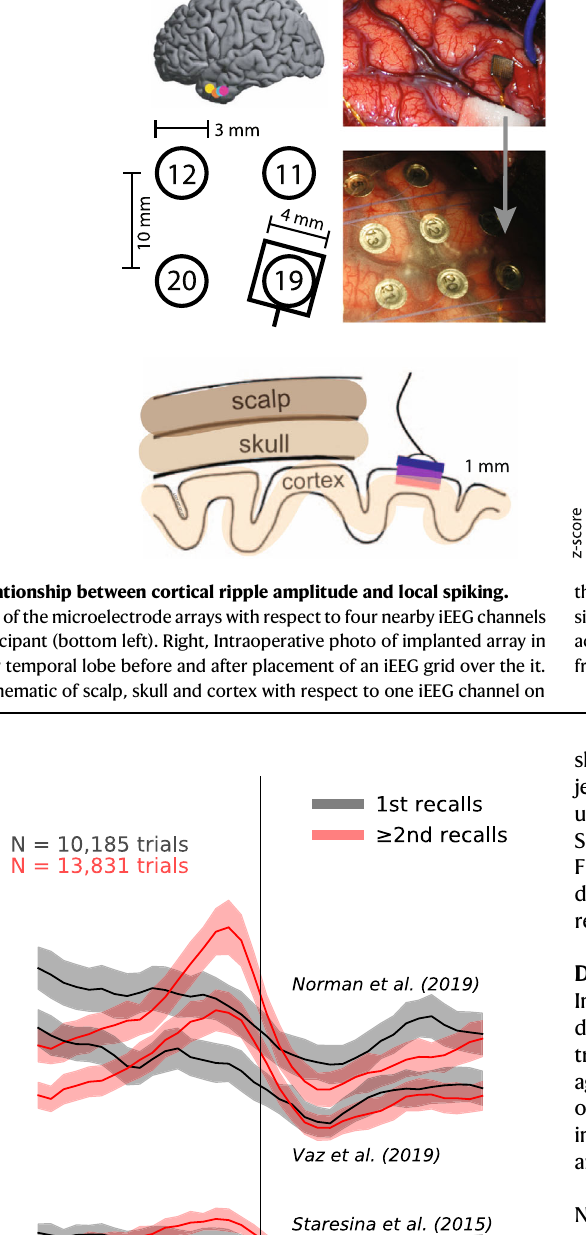
Fig. 5 | SPW-Rs aligned to verbal recall for three different detection methods. HumanintracranialhippocampalCA1recordingsweretakenwhilepatients( n =96) performed a free recall task from a 12-word list (from ref. 109). Recalls were split into the fi rst recall and the remaining ( ≥ 2nd) recalls from each list. Ripples were detected using three different published methods (refs. 34, 36, 111) and peri- vocalization time histograms were averaged across trials pooled for all patients using 100ms bins and a 5-point triangle smooth. While the rise in ripples before recall vocalization for ≥ 2nd recalls compared to 1st recalls is statistically different forallthreedetectors,thedetectedrippleratesvaryseveral-folddependingonthe detection method. Figure courtesy of John